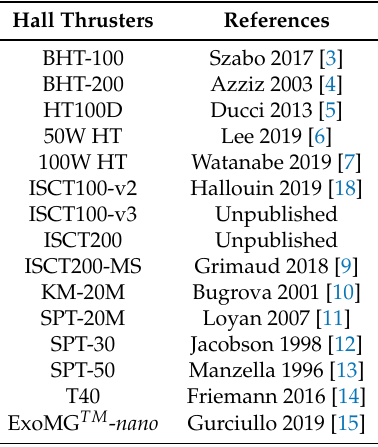
Table 1. Sources of thruster performances presented in Figure 1.